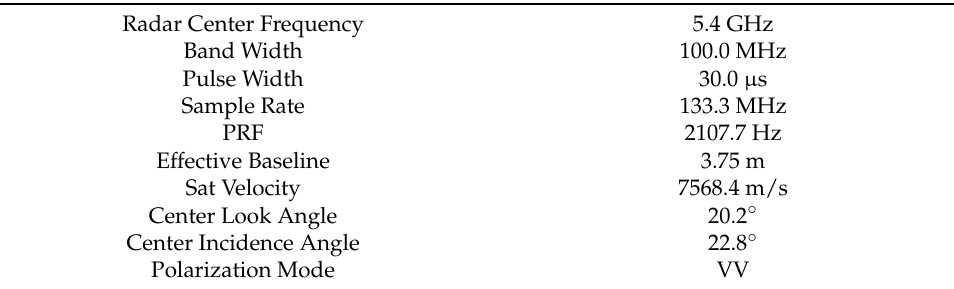
Figure 13. The phase imbalances of the reference land scene and ocean scene for ocean current inversion. ( a ) The GF-3 image of the reference land scene; ( b ) the phase imbalances of the reference land scene; ( c ) the GF-3 image of the ocean scene; ( d ) the phase imbalances of the ocean scene. Table 8. Product